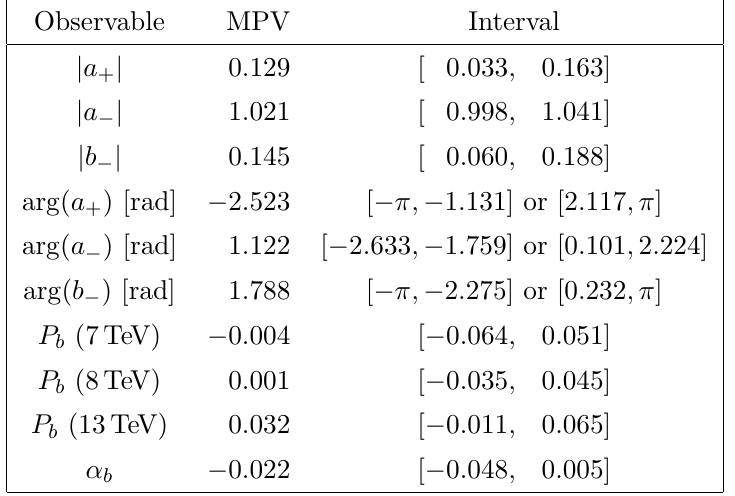
Table 5 . Estimates for the magnitude and phase of the decay amplitudes and the transverse production polarisation of the (cid:3) 0 baryons, extracted using the Bayesian analysis. The most probable b value (MPV) and the shortest 68% interval containing the most probable value are